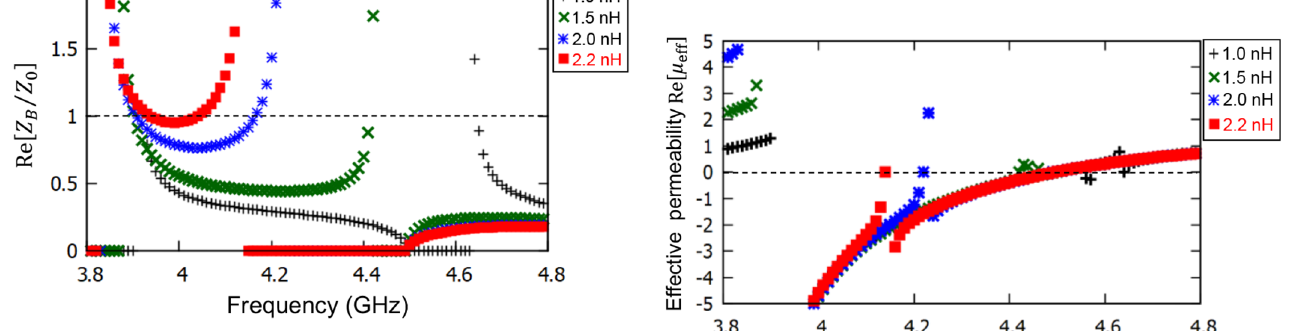
Fig. 4. Simulated real part of the Bloch impedance for the composite structures loaded with the lumped inductors as a function of the inductance L .